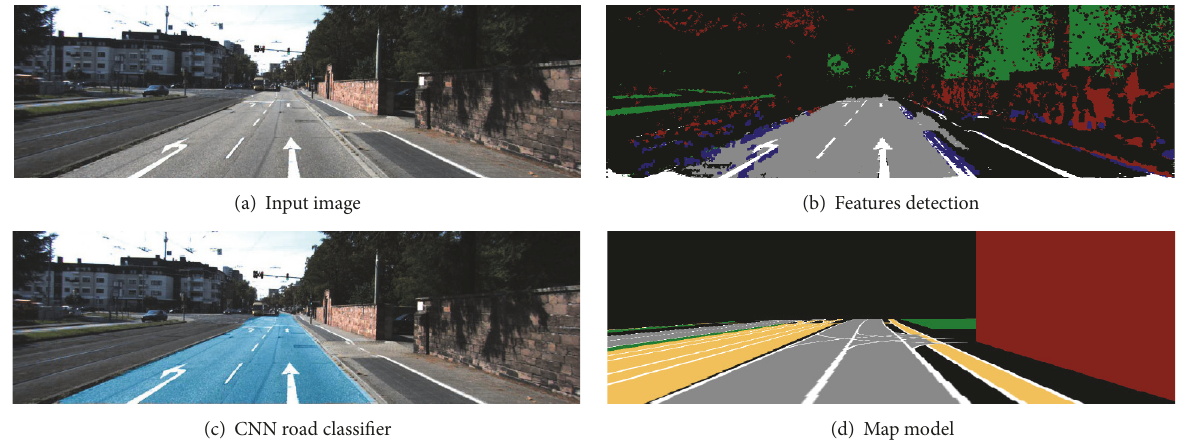
Figure 14: The use of a map model increases the robustness of a road classifier because the other boundary features compensate some road missclassifications.